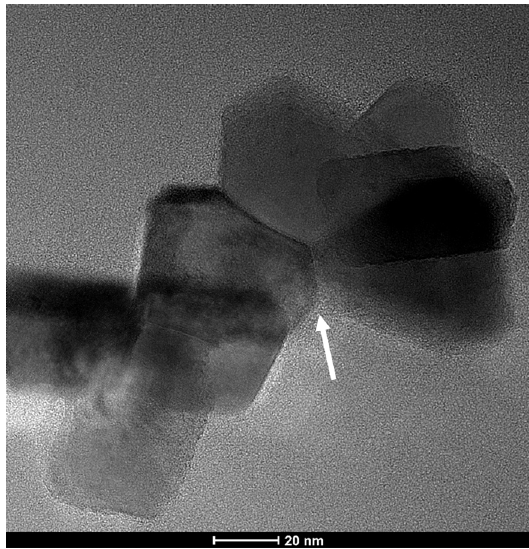
Figure 3. High-Resolution TEM image of NR750 showing grain boundary formation, indicating the occurrence of sintering of TiO nanoparticles.